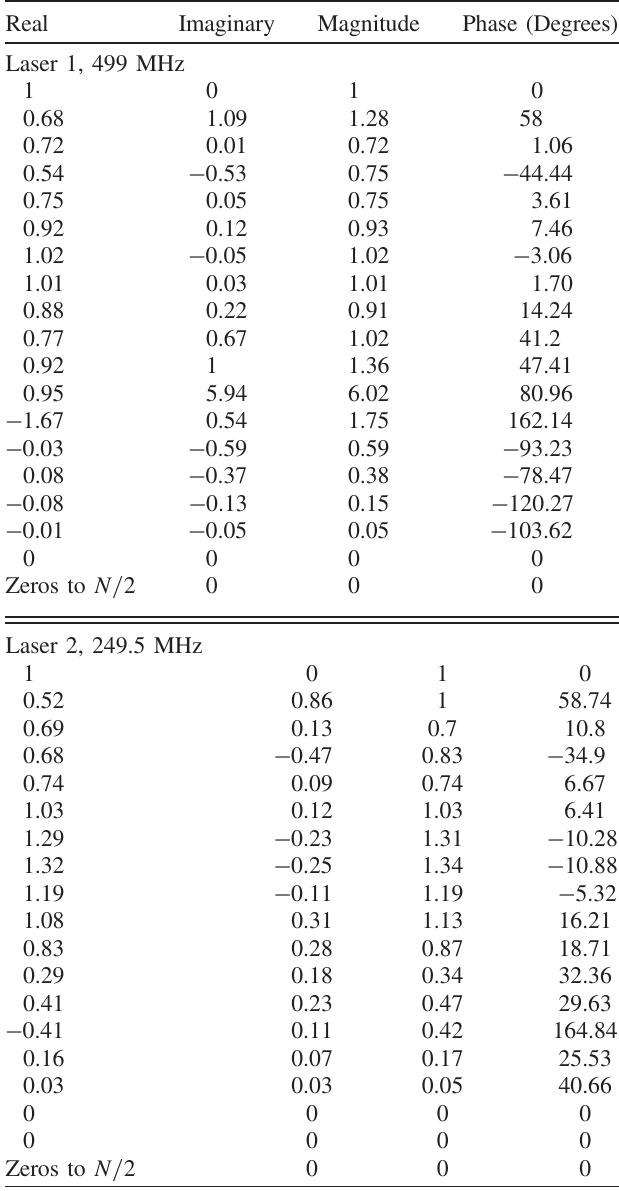
TABLE I. The transfer functions for the harmonically resonant cavity installed at the CEBAF photoinjector for different drive laser